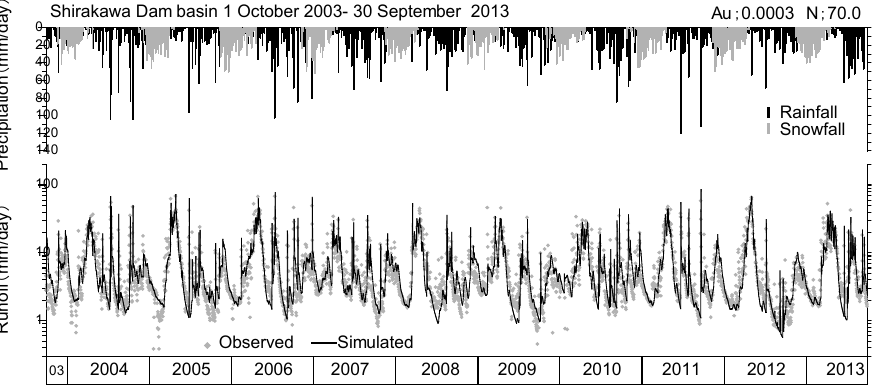
Fig. 5 An example of simulated mean daily hydrograph for the SIRA basin using the optimized parameters of Au = 0.0003 and N = 70.0.